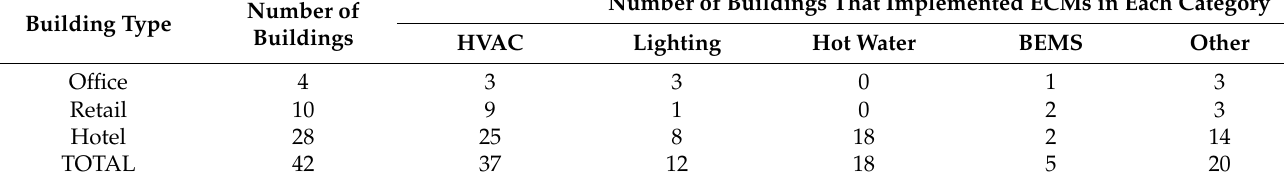
Table 3. Summary of energy conservation measures (by building type).